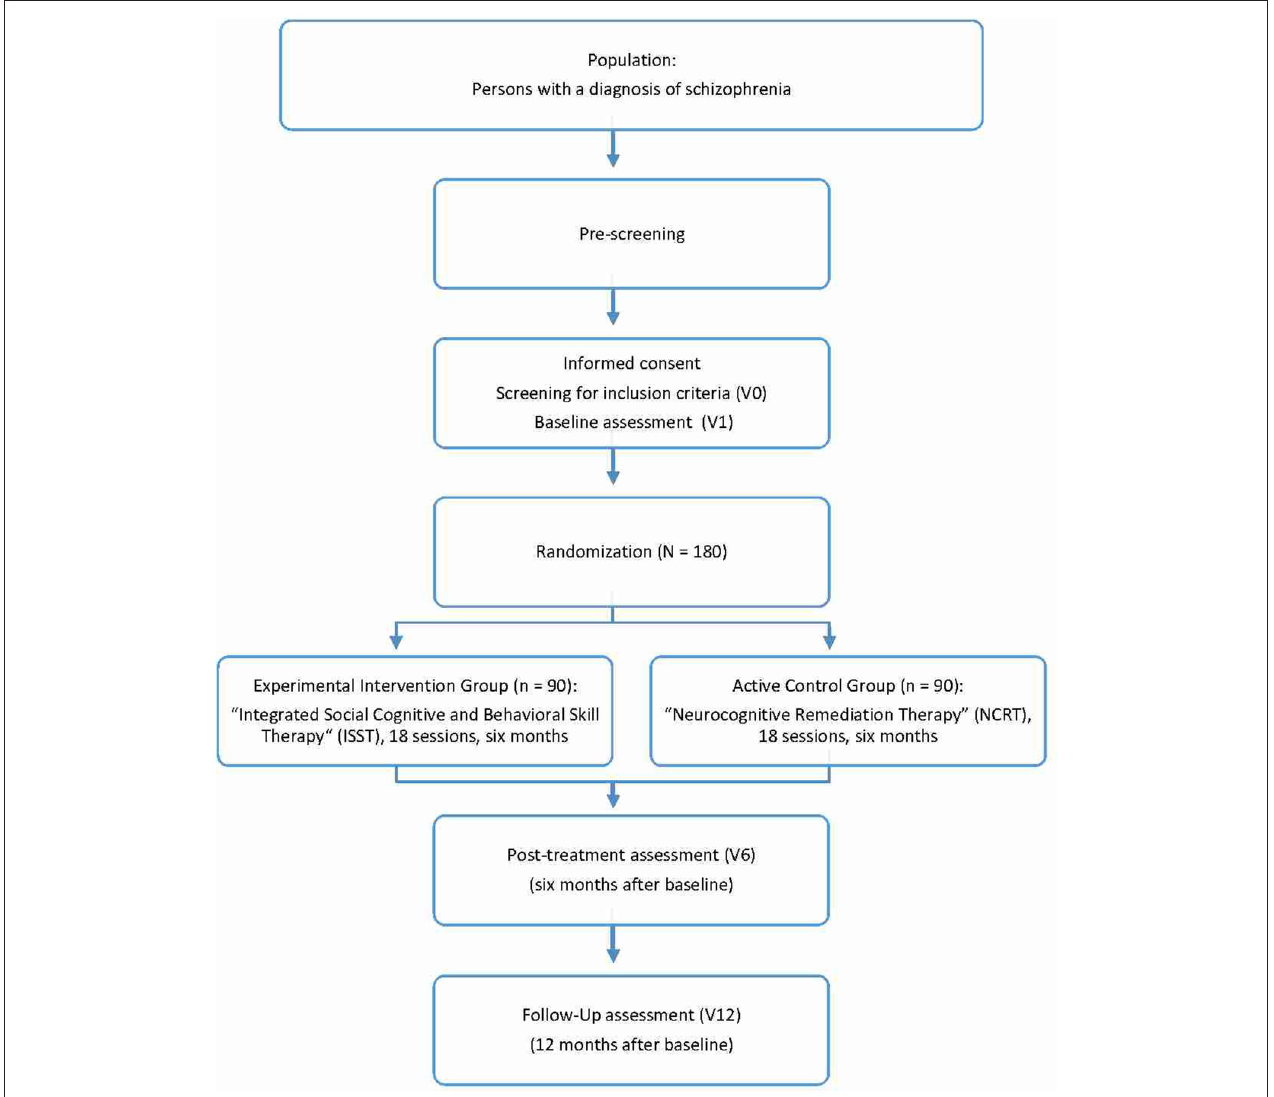
FIGURE 1 | Overview of the trial.